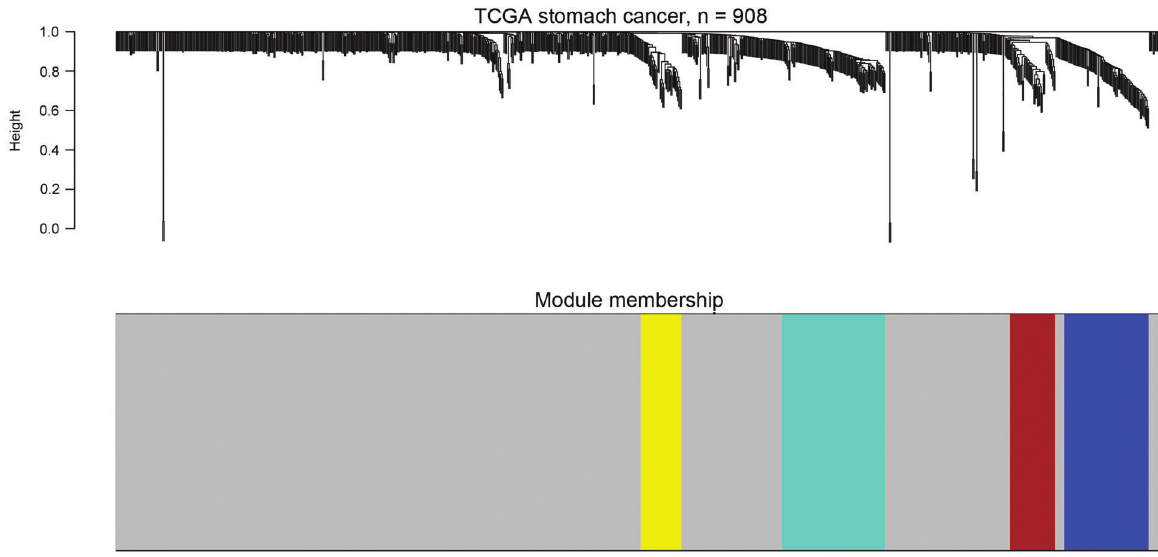
Figure 4. Clustering results of gene modules in co-expression network. Top , hierarchical clustering of 908 genes in co-expression network. Bottom , divisional module classes. Gray zones indicate genes that do not belong to any